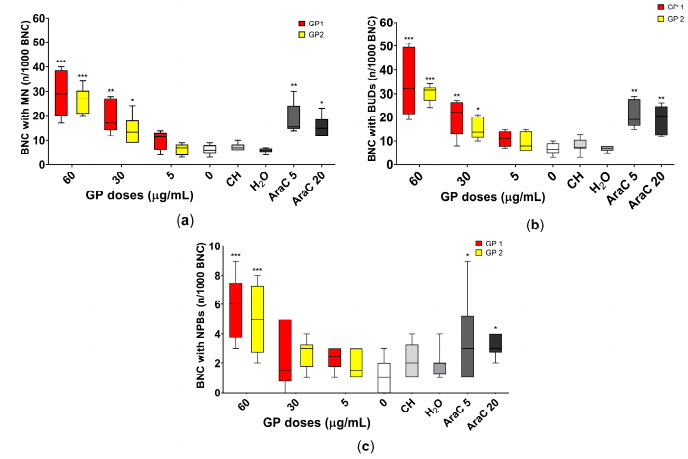
Figure 5. Assessment of the DNA damage of THP-1 cells after 40 h of exposure to two types of graphene platelets (GP1, GP2) in a concentration of 0–60 µg/mL by CBMN. Assessment of ( a ) number of binucleated cells (BNC) with micronuclei (MN); ( b ) BNC with nuclear buds (BUDs); ( c ) BNC with nucleoplasmic bridges (NPBs). Data are presented in a boxplot with a median in the interquartile range. CH—sodium cholate (in a concentration corresponding to 60 µg/mL); H 2 O—water (in a concentration corresponding to 60 µg/mL); AraC 5 or 20—cytosine arabinoside (in concentrations of 5 and 20 ng/mL); * p -value < 0.05; ** p -value < 0.01; *** p -value < 0.001.